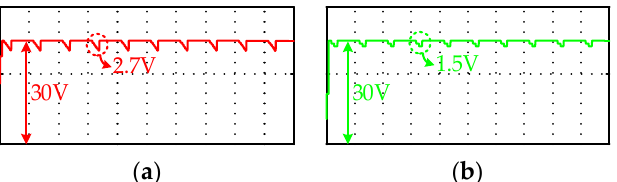
Figure 7. Comparison of voltage ripple under di ff erent capacitance. ( a ) The capacitance is 2200 µ F. ( b ) The capacitance is 4700 µ F.